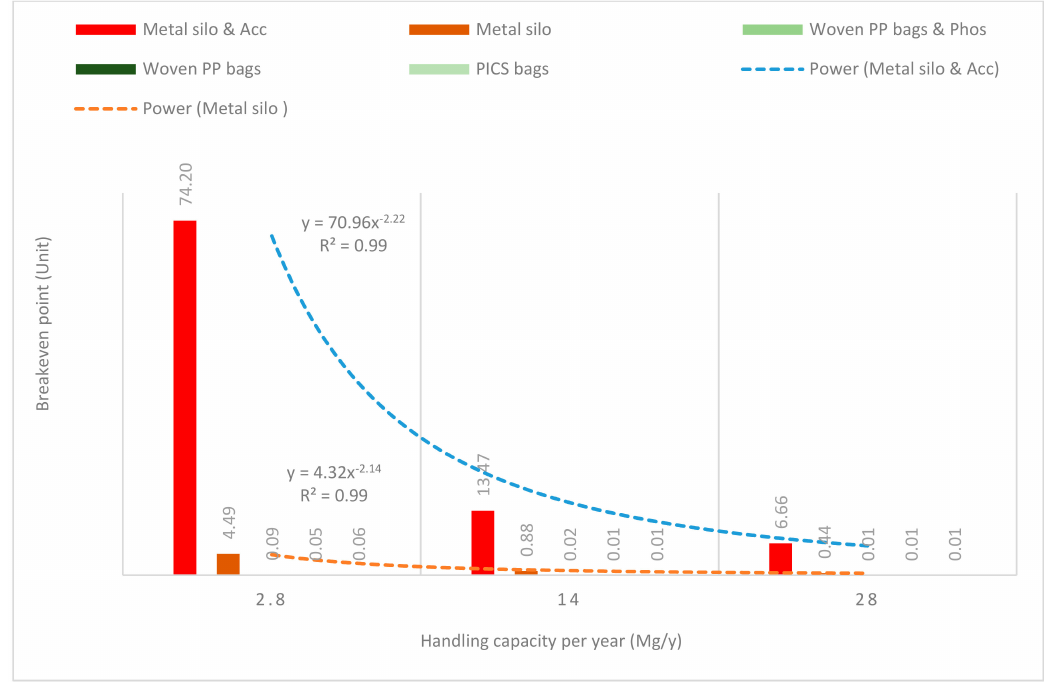
Figure 13. Breakeven results (the quantity of a particular handling capacity needed to breakeven) for each maize handling method per handling capacity /